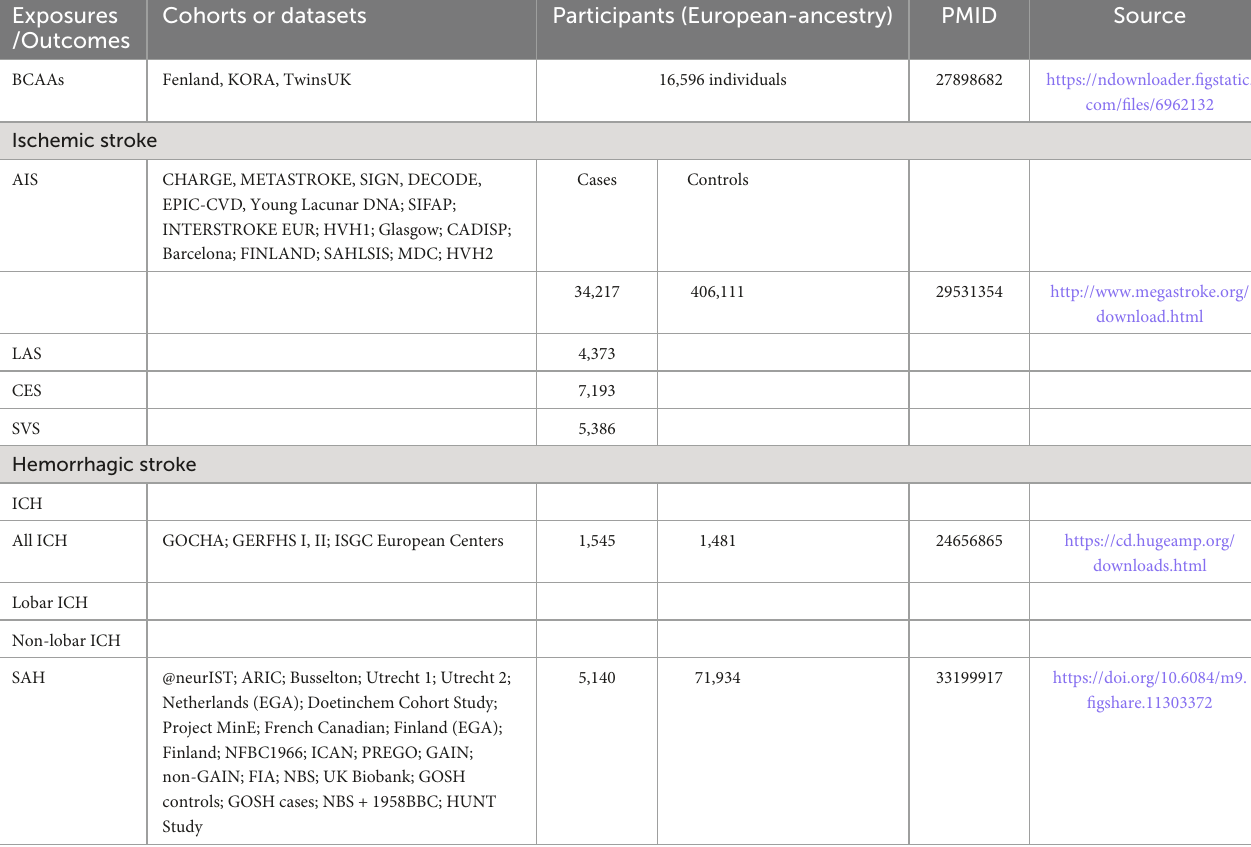
TABLE 1 Summary of detailed information on genome-wide association studies and datasets included in present